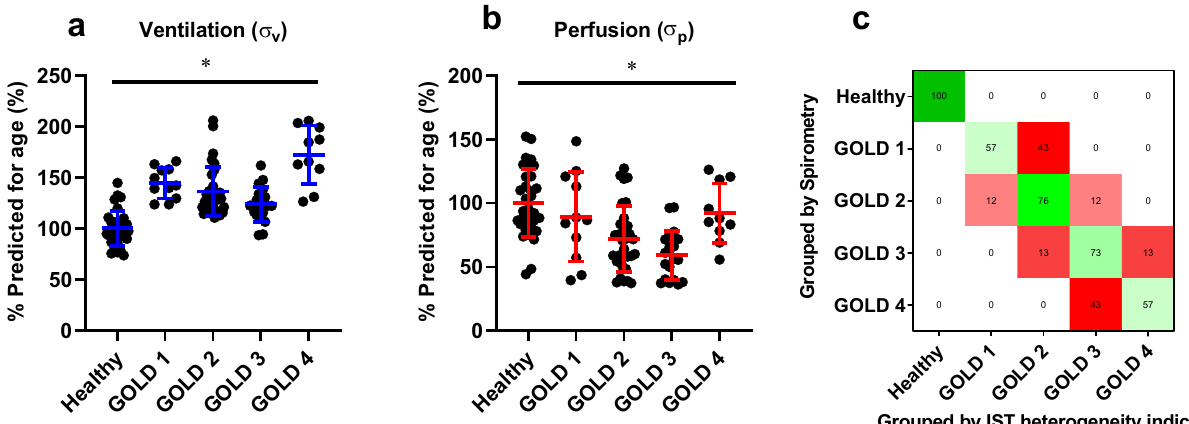
Figure 4. The IST heterogeneity results in the human data set, including healthy and COPD phenotypes (GOLD 1–4). Panels ( a ) and ( b ) show % of measured values over the predicted values for age in different lung conditions. Kruskal–Wallis test was applied for multiple groups comparison with abnormal distribution. Panel ( c ) shows the confusion matrix result of the logistic regression analysis in percentage. This analysis grouped patients by the IST heterogeneity indices and compared them with the classification results using Spirometry (standard method). * p <